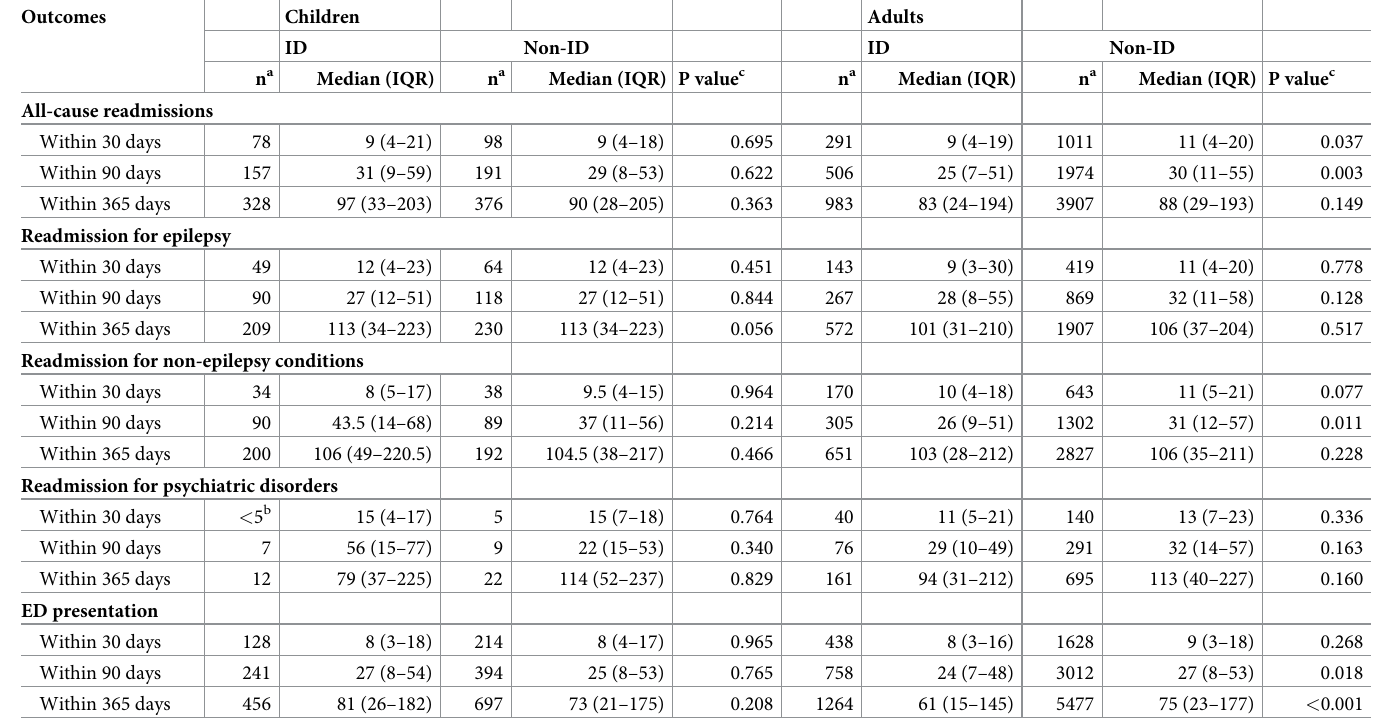
Table 3. Days to the first outcome (median, IQR) within each follow-up period for people with and without intellectual disability with at least one